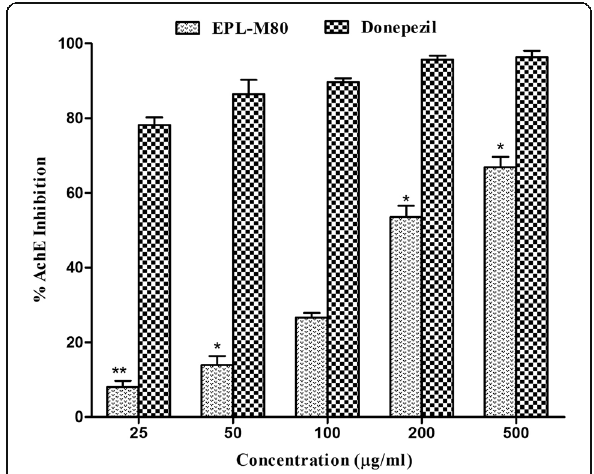
Fig. 1 Percentage of inhibition of acetylcholinesterase activity at different concentration of EPL-M80 and the reference standard donepezil. Results are presented as mean ± SEM ( n = 3). * p < 0.05 and ** p < 0.01 denote significant difference compared to the control